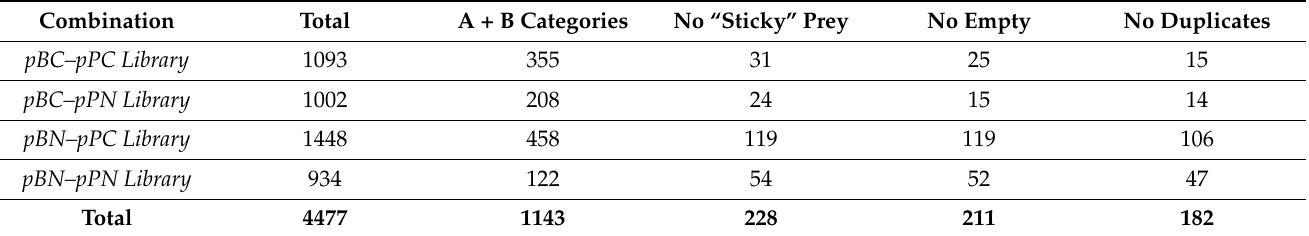
Table 2. Total number of interactions detected by the Y2H screening after each filtering